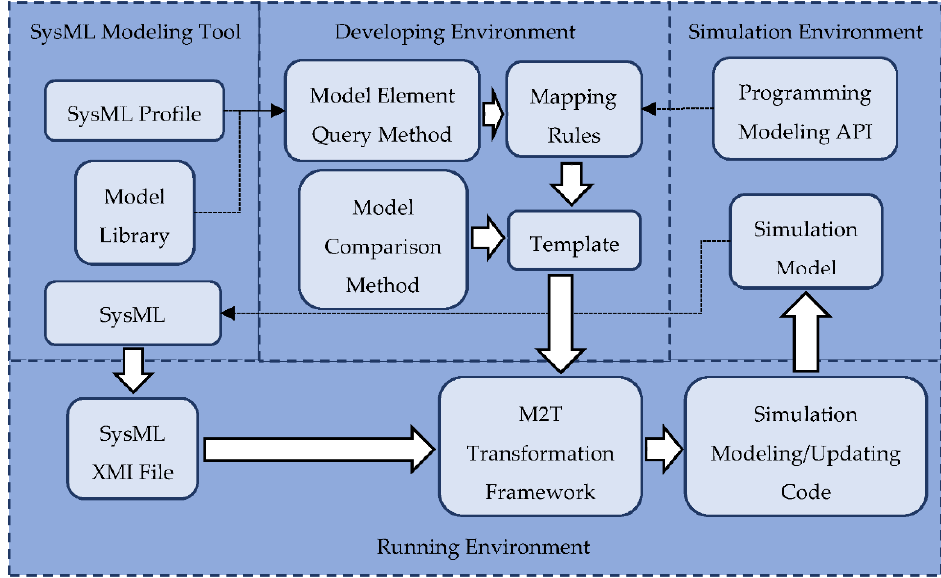
Figure 3. System model–simulation model synchronization–conversion process .